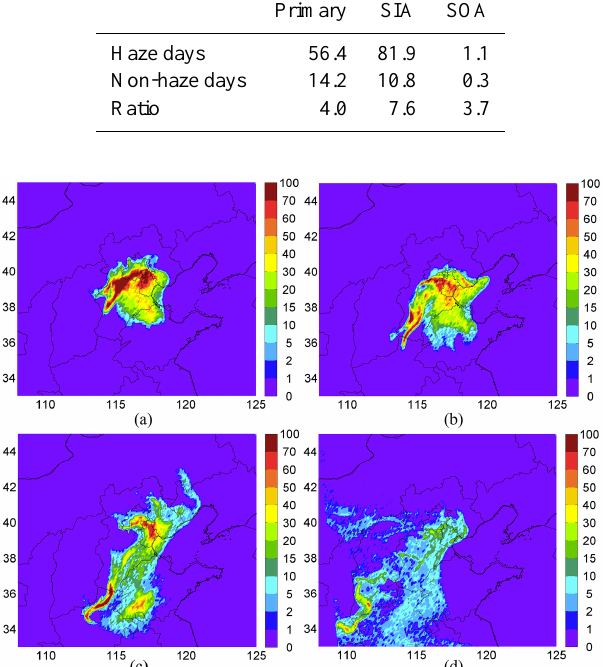
Figure 12. Backward dispersion of particles released on 19 January 00:00, plotted 6, 12, 24, and 48h before being released (unit: num- ber/grid cell).